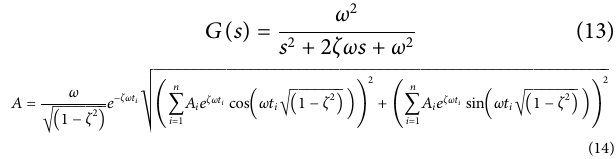
Frontiers in Robotics and AI |